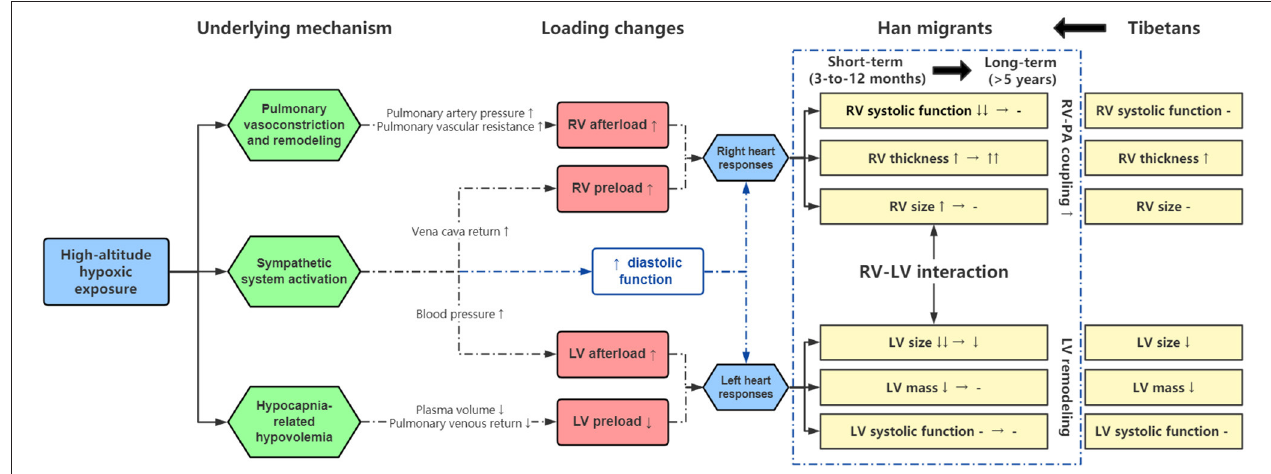
FIGURE 3 | Summary of cardiac adaptations to prolonged exposure to chronic hypoxia. Refer to text for